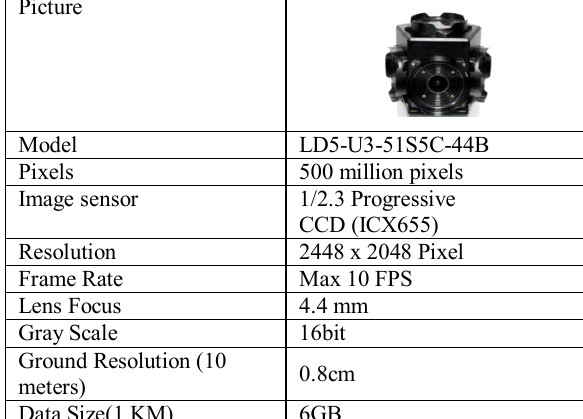
Table 3. Our LiDAR system